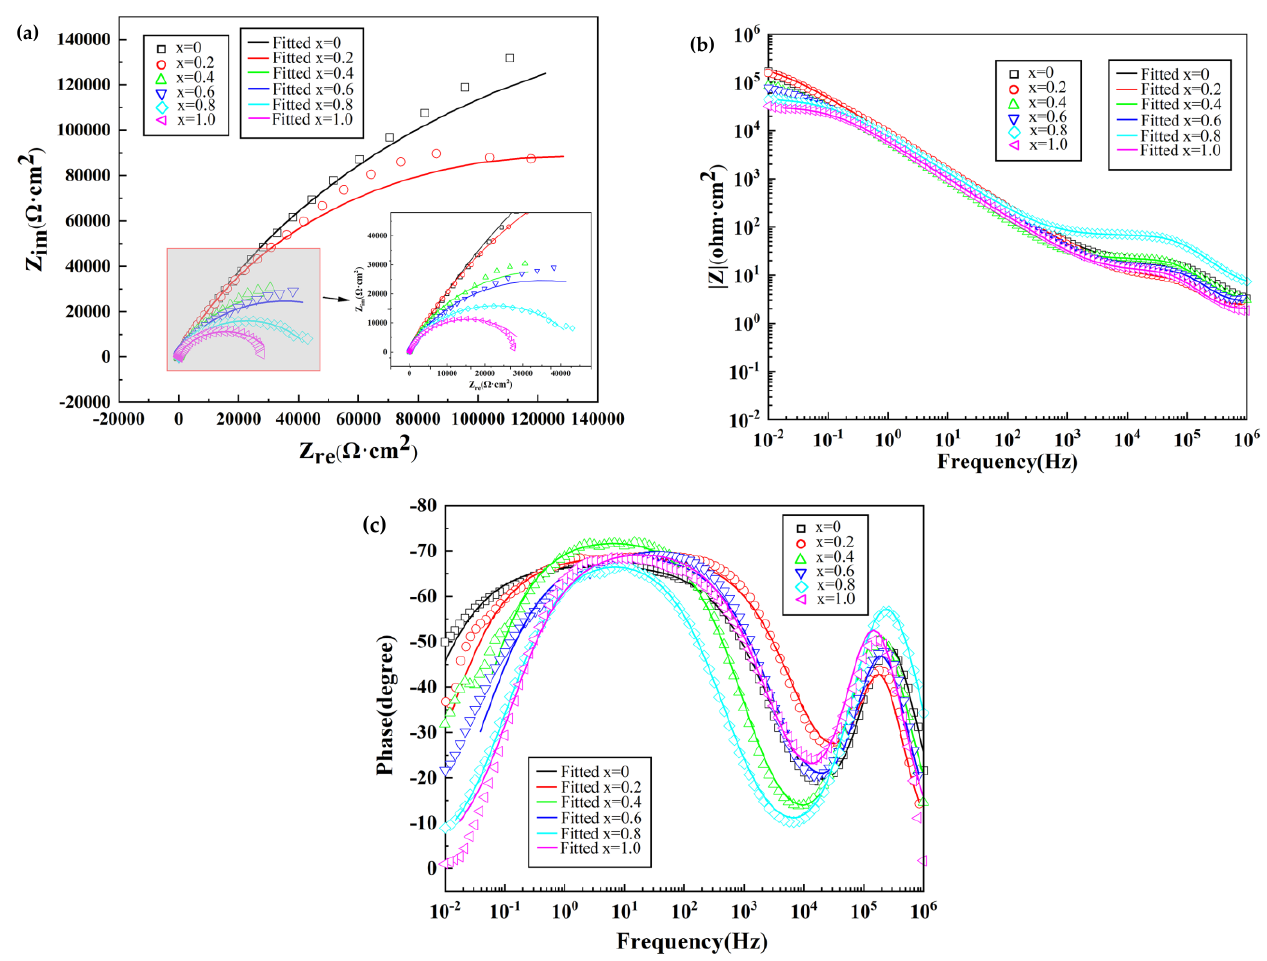
Figure 6. Fitted electrochemical AC impedance of AlCrTiV 0.5 Cu x lightweight HEAs in 0.6 M NaCl solution. ( a ) Nyquist plot; ( b ) Bode plot; ( c ) Phase angle plot.